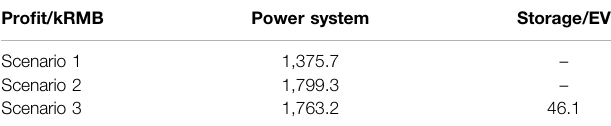
TABLE 7 | Pro fi ts of grid and storage/EV under each